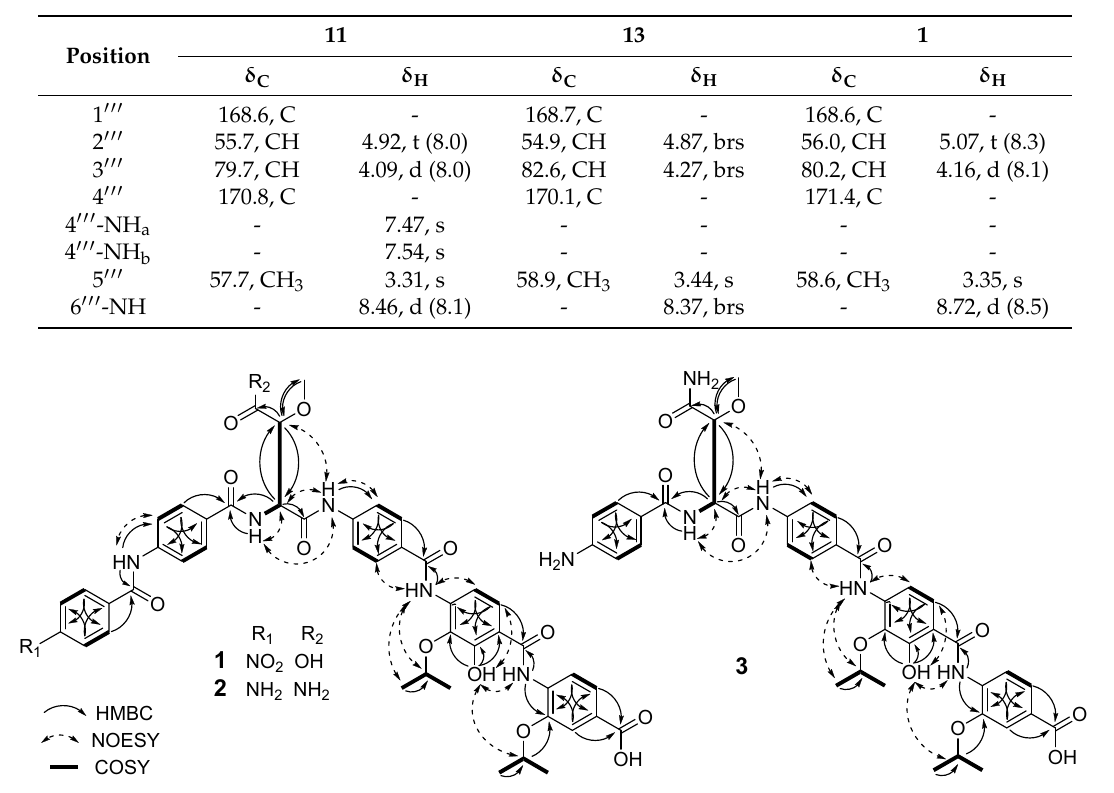
Figure 2. Key HMBC, COSY, and NOE correlations of 1 – 3 .